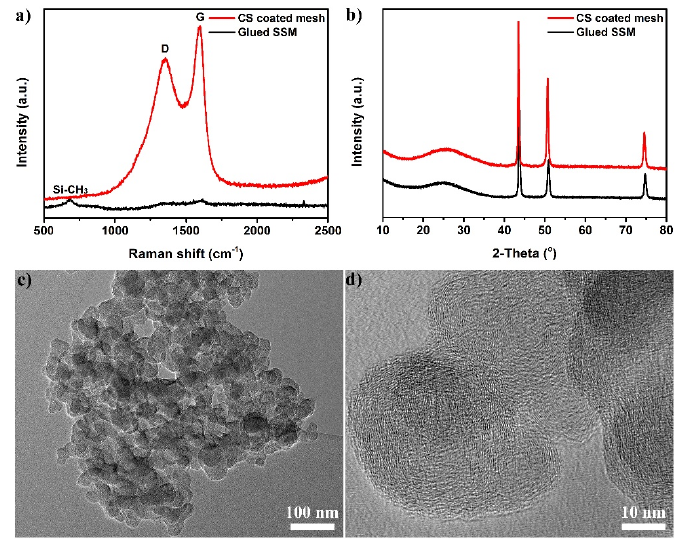
Figure 3. ( a ) Raman spectra and ( b ) XRD patterns of the glued SSM and CS-coated mesh. ( c , d ) Low- and high-magnification TEM images of the CS product.